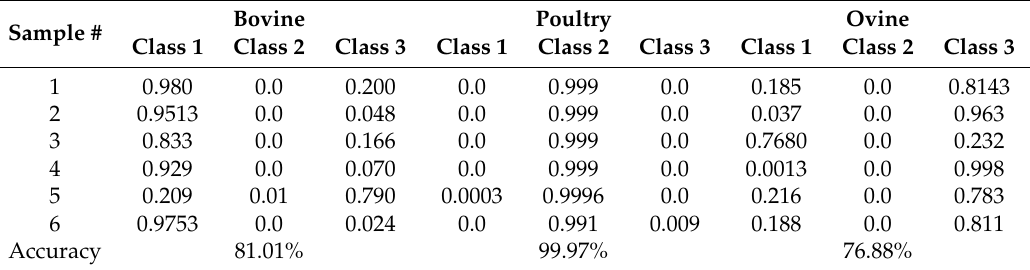
Table 5. Bovine, Ovine and Poultry minced meat classification performance; class1, class2 and class3 represent Bovine, Poultry and Ovine, respectively.